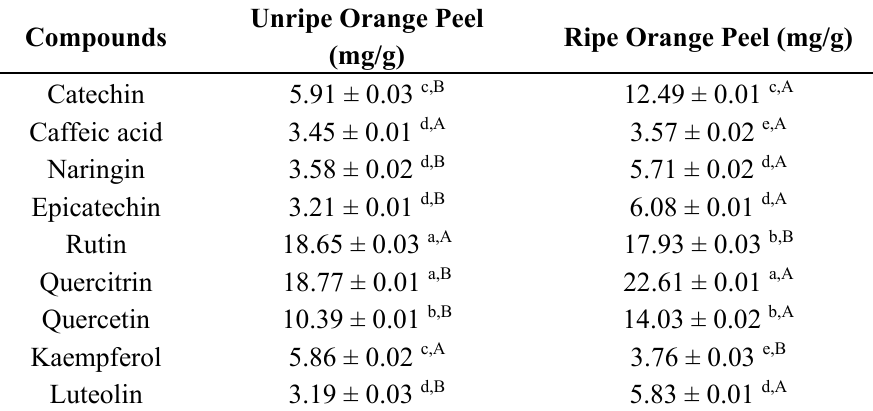
Table 1. Phenolic acids and flavonoids composition of orange peel powder (ripe and unripe)